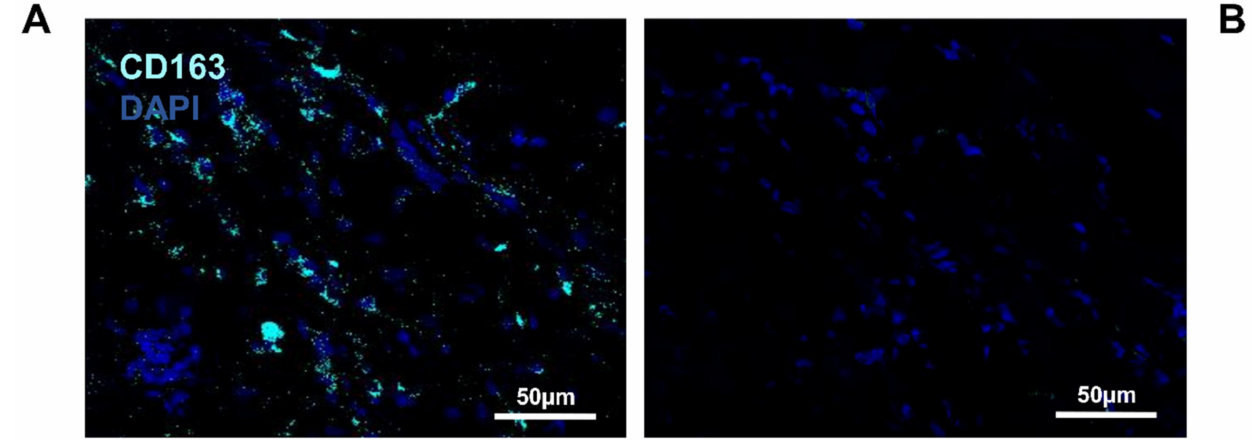
Figure 4. Identification of M2-like macrophages in the operated femur: ( A ) immunolabeling of the operated femur with anti-CD163; ( B ) negative control of the immunolabeling; anti-CD163 (Alexa488, turquoise fluorescence), labeling the M2 macrophages; nuclear staining with DAPI (blue